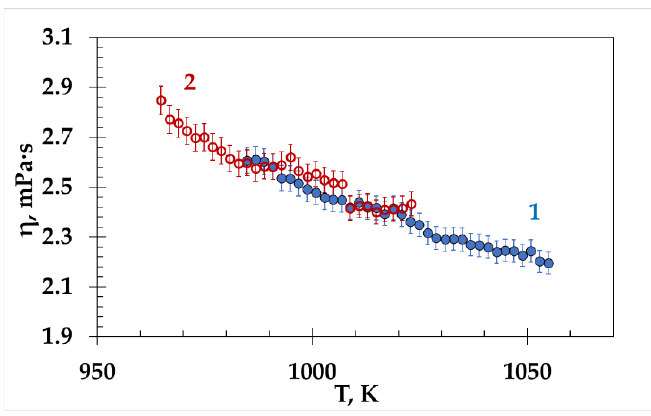
Figure 7. Viscosity of (NaF - KF) eut (1) and (LiF - NaF - KF) eut (2) .